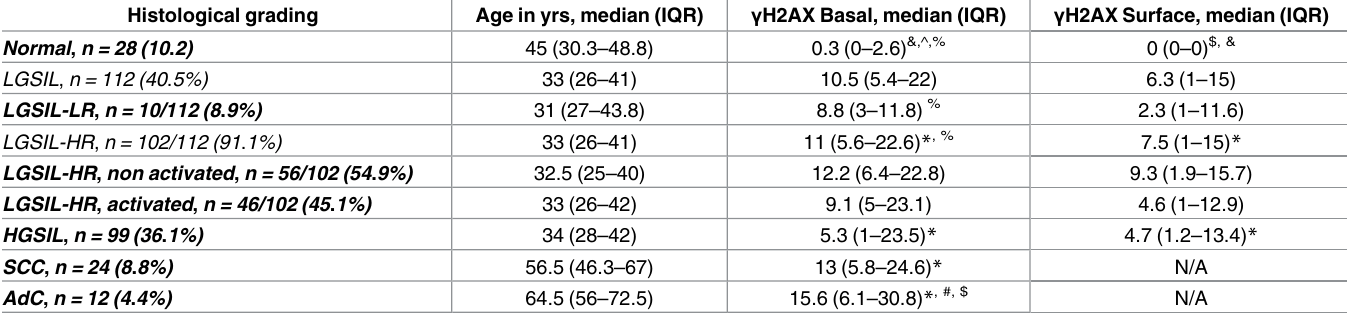
Table 2. γ H2AXexpression(basal and surfacesegments of epithelium) across histologically confirmed lesions for all patients with available data. Statistically significantassociations (p < 0.05)by ANOVA are flagged. Histological grading